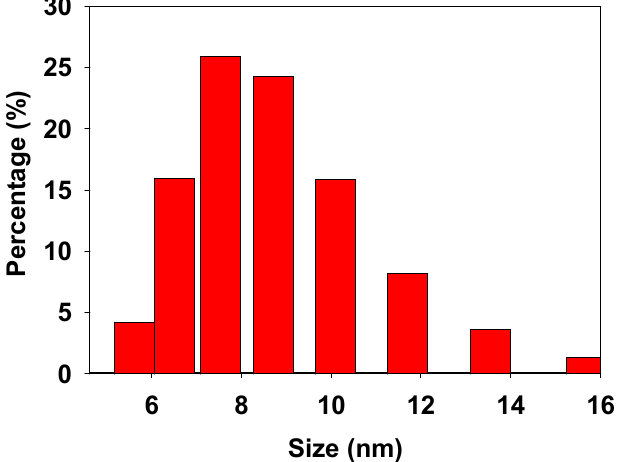
Figure 2. Size distribution of TiO 2 NPs determined by DLS.